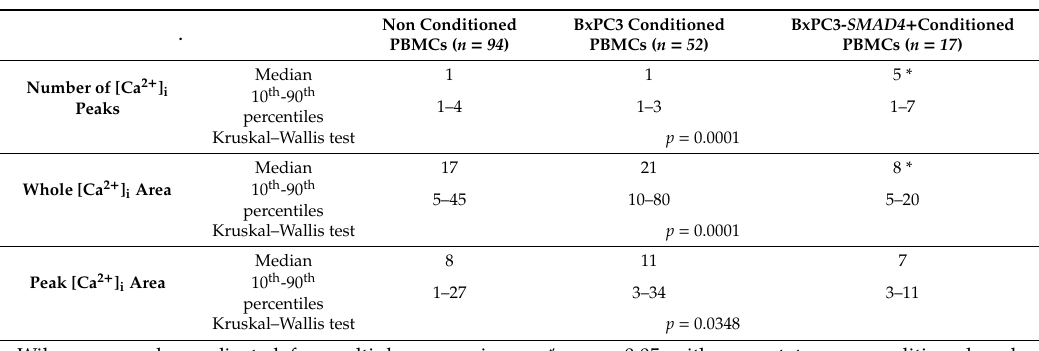
Table 2. The e ff ects of pancreatic ductal adenocarcinoma (PDAC)conditioned media on the intracellular calcium [Ca 2 + ] i of PBMCs. PBMCs were cultured for 3 days in non-conditioned medium, BxPC3, or BxPC3- SMAD4 + conditioned media. The data reported are from four independent experiments, and the total number of single cells analyzed is reported in